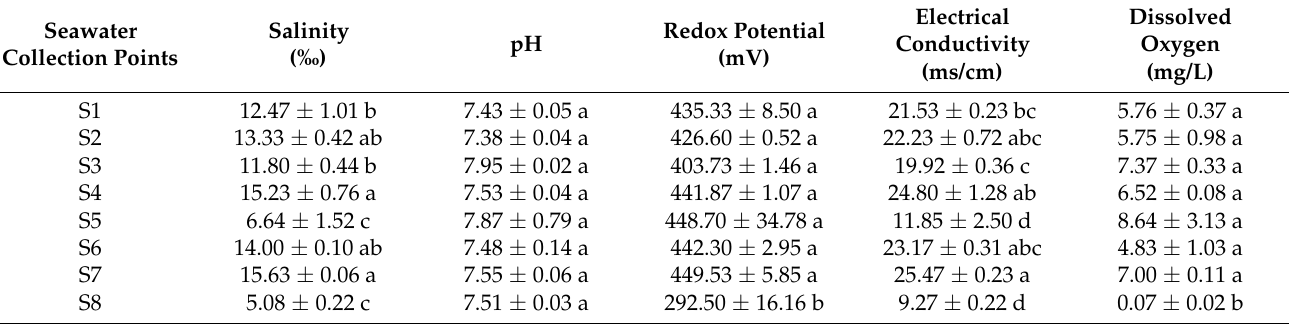
Table 5. Physicochemical properties of seawater near K. obovata and S. caseolaris communities on the west coast of Bao’an, Shenzhen. Mean ± SD of three replicates were shown. Different small letters indicate significant differences among various physicochemical parameters from the 8 seawater collection points at p <